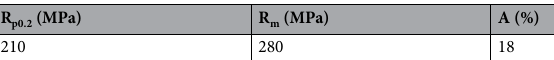
Table 4. Tensile properties of the S Al 5087 filler material.